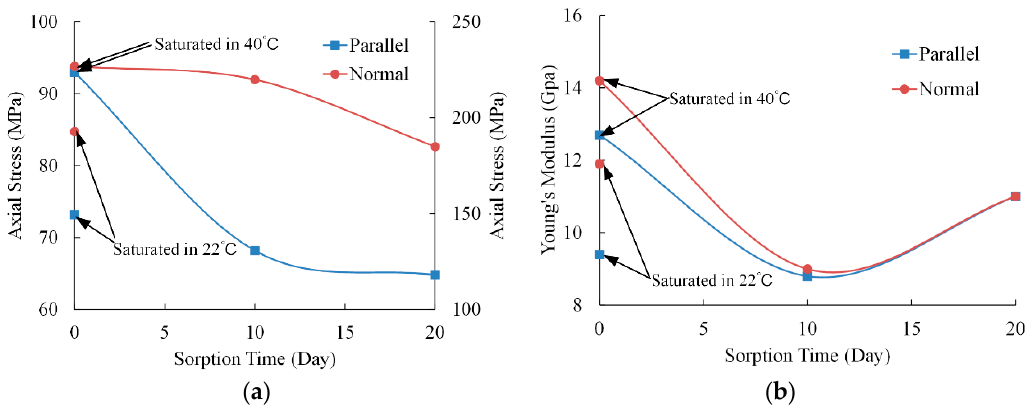
Figure 2. Effects of saline concentration on shale samples’ ( a ) axial stress and ( b ) Young’s modulus.